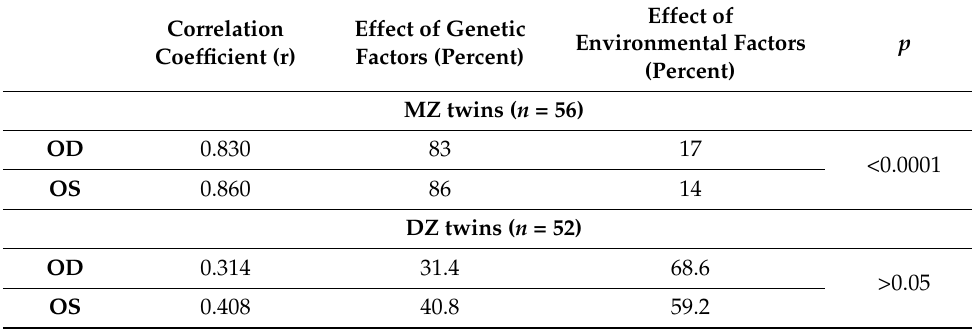
Table 2. Correlation of MPOD values between MZ and DZ twins.